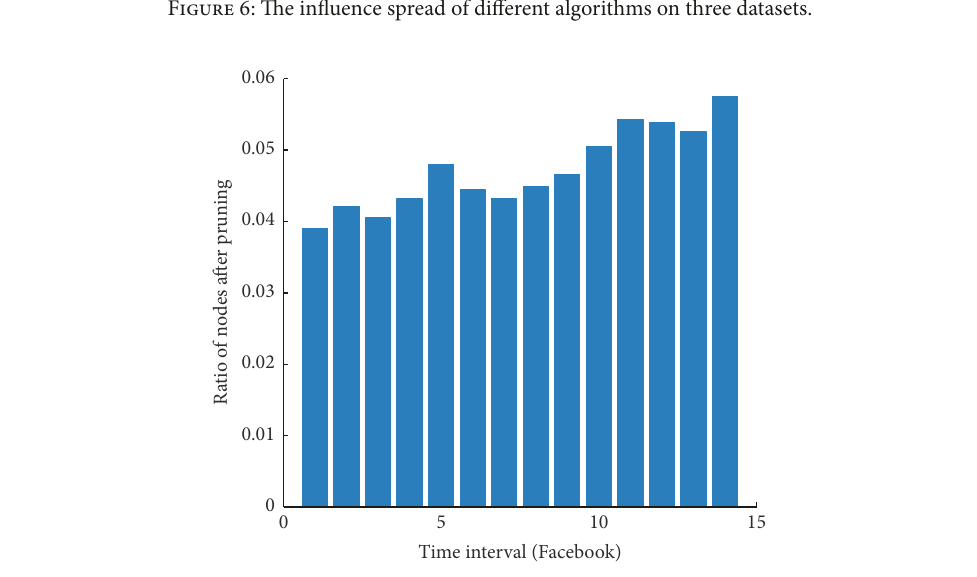
Figure 6: The influence spread of different algorithms on three datasets.